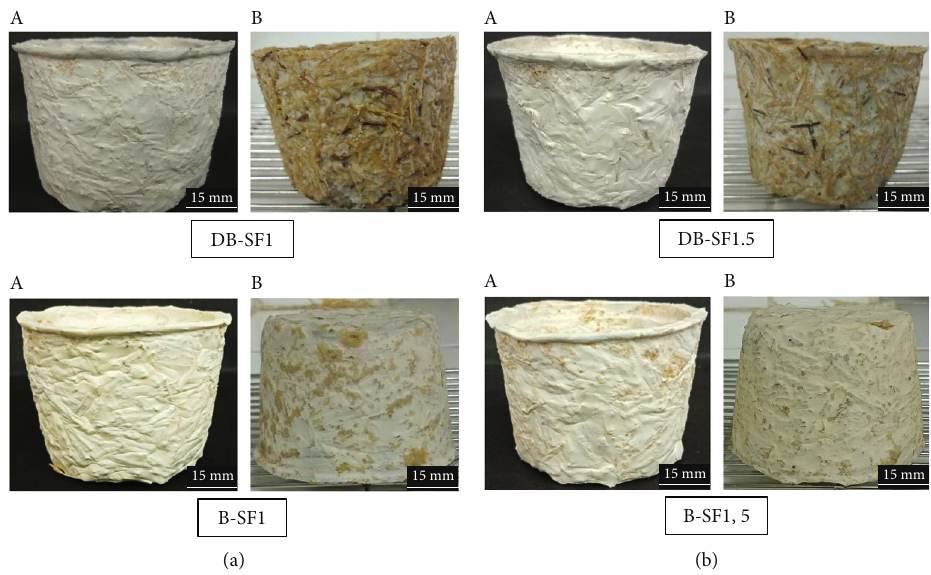
Figure 5: The appearance of the surface of the biofoam cup with 1x magnitude before soaking (a) and after soaking (b) where DB is depithed bagasse, B is bagasse, SF1 is the ratio of soybean fl our to bagasse = 1 , and SF1.5 is the ratio of soybean fl our to bagasse = 1 : 5